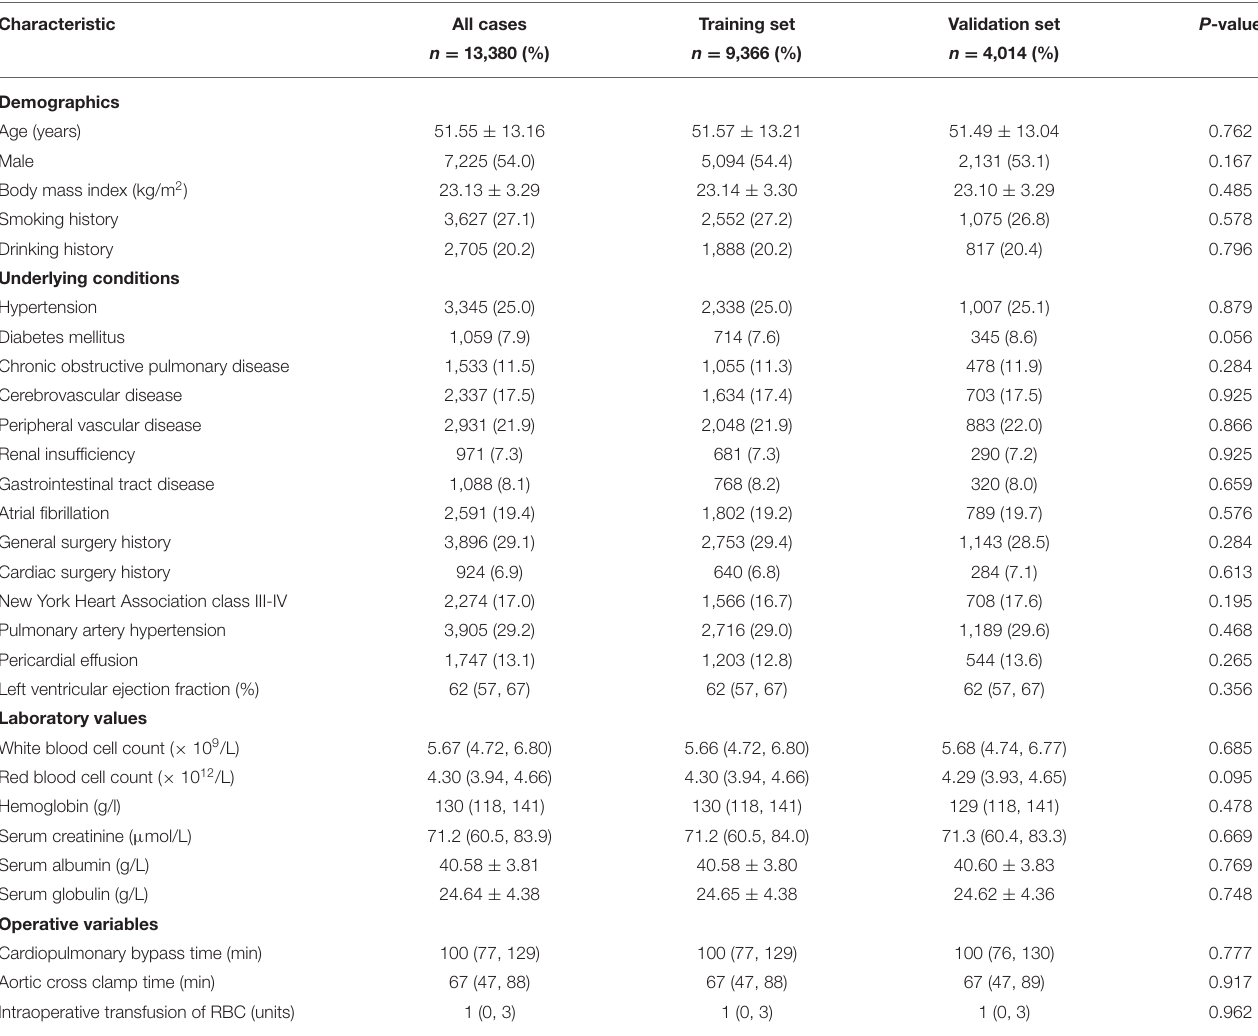
TABLE 1 | Comparison of characteristics between the training and validation sets. Characteristic All